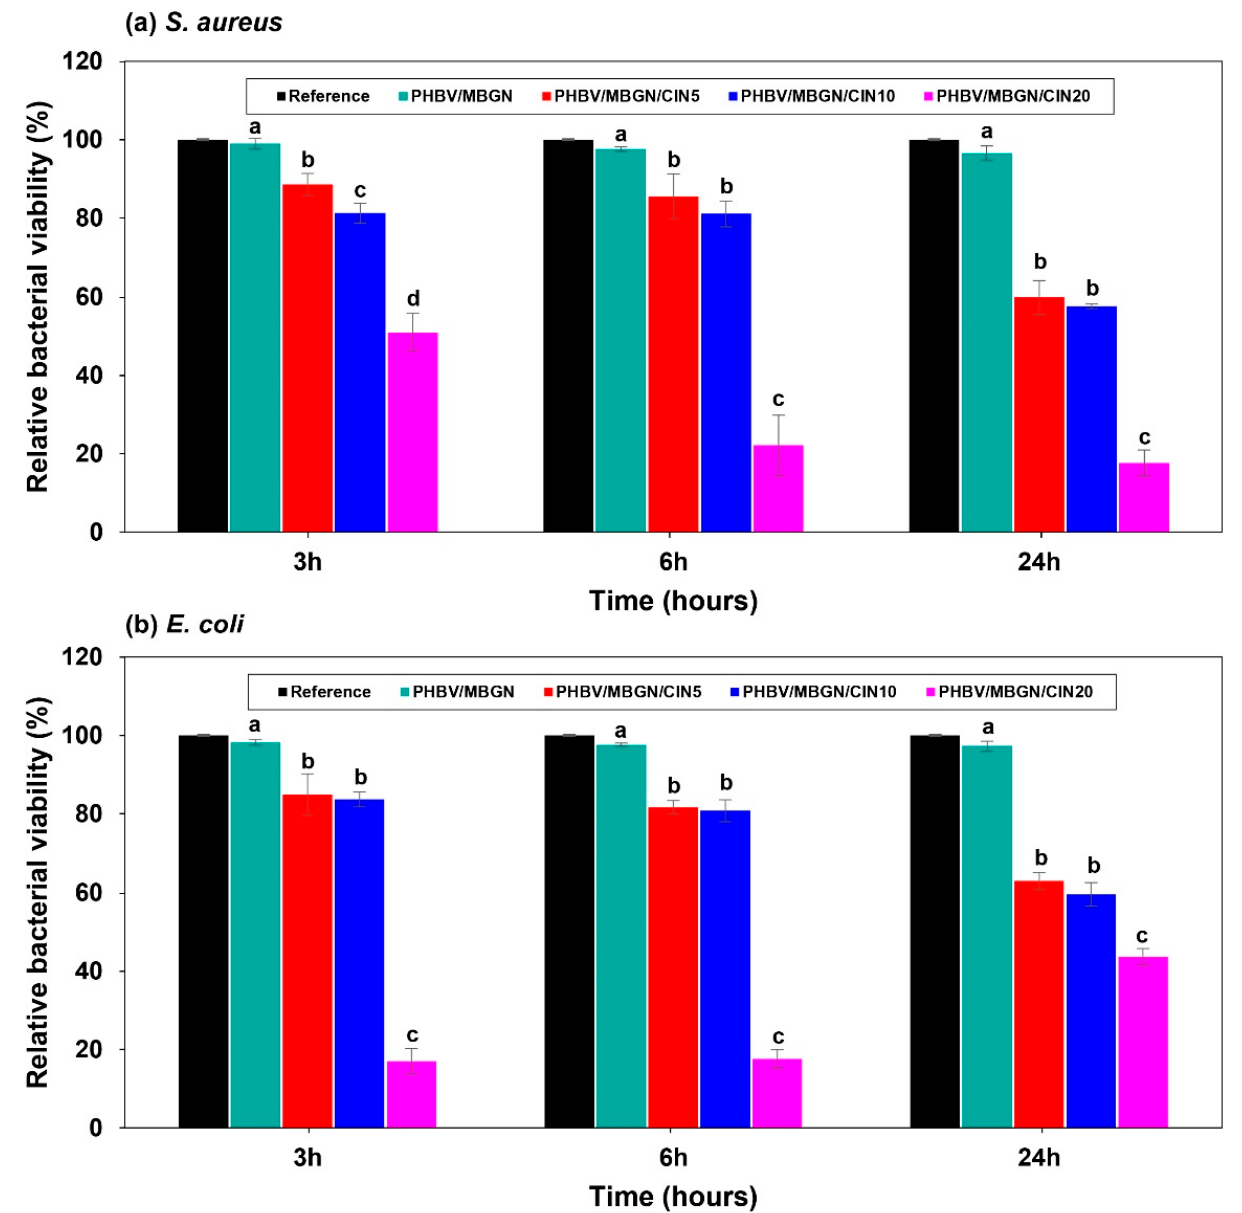
Figure 4. Relative viability of ( a ) Staphylococcus aureus and ( b ) Escherichia coli on different concentrations of CIN-loaded PHBV/MBGN microspheres (PHBV/MBGN/CIN5, PHBV/MBGN/CIN10, and PHBV/MBGN/CIN20) at 3, 6, and 24 h incubation. Bacterial viability in free microspheres’ medium was used as reference. Experimental data are reported as mean ± standard deviation. n = 3. Means followed by the different letters within columns indicate a significant difference at p < 0.05 using Duncan’s new multiple range test. Each different time point was analyzed